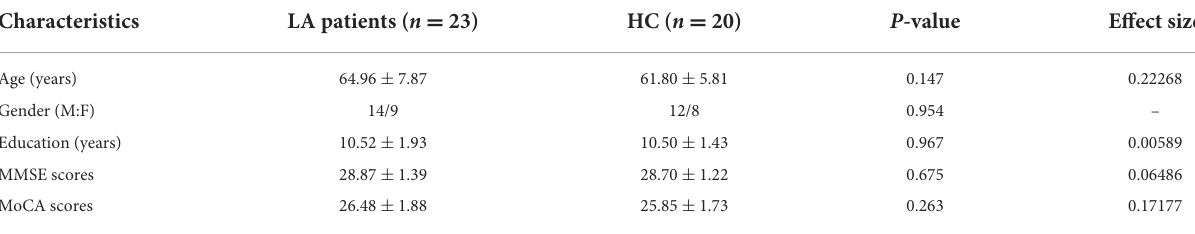
TABLE 1 The detailed information about demographic and neuropsychological data in patients and control participants.